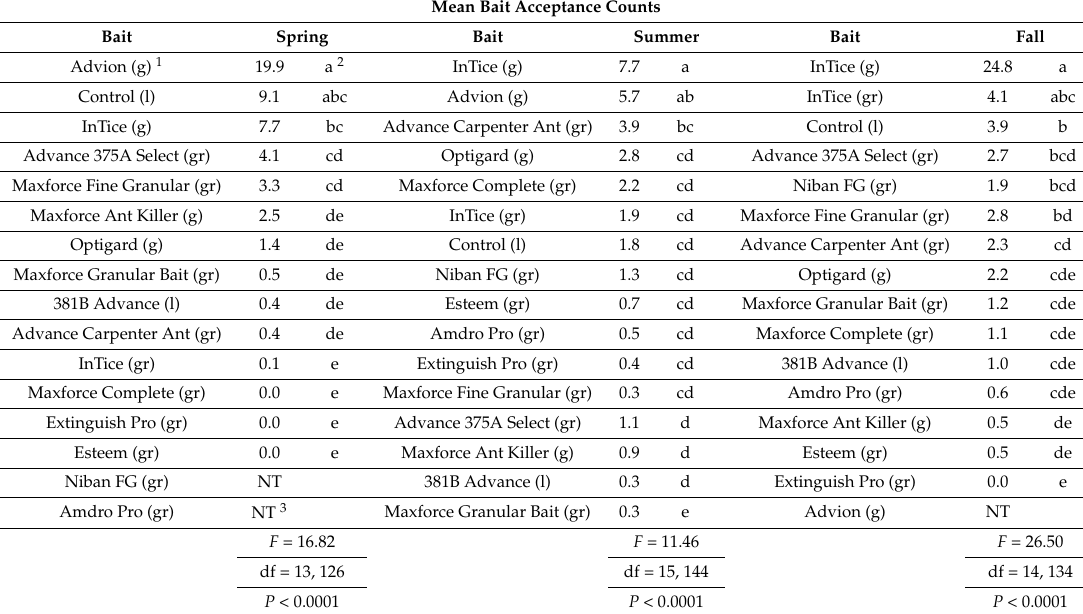
Table 4. Nylanderia fulva acceptance of 15 commercially available baits in no-choice laboratory assays over three seasons (2009–2010) (n = 10 replications for each bait per season).